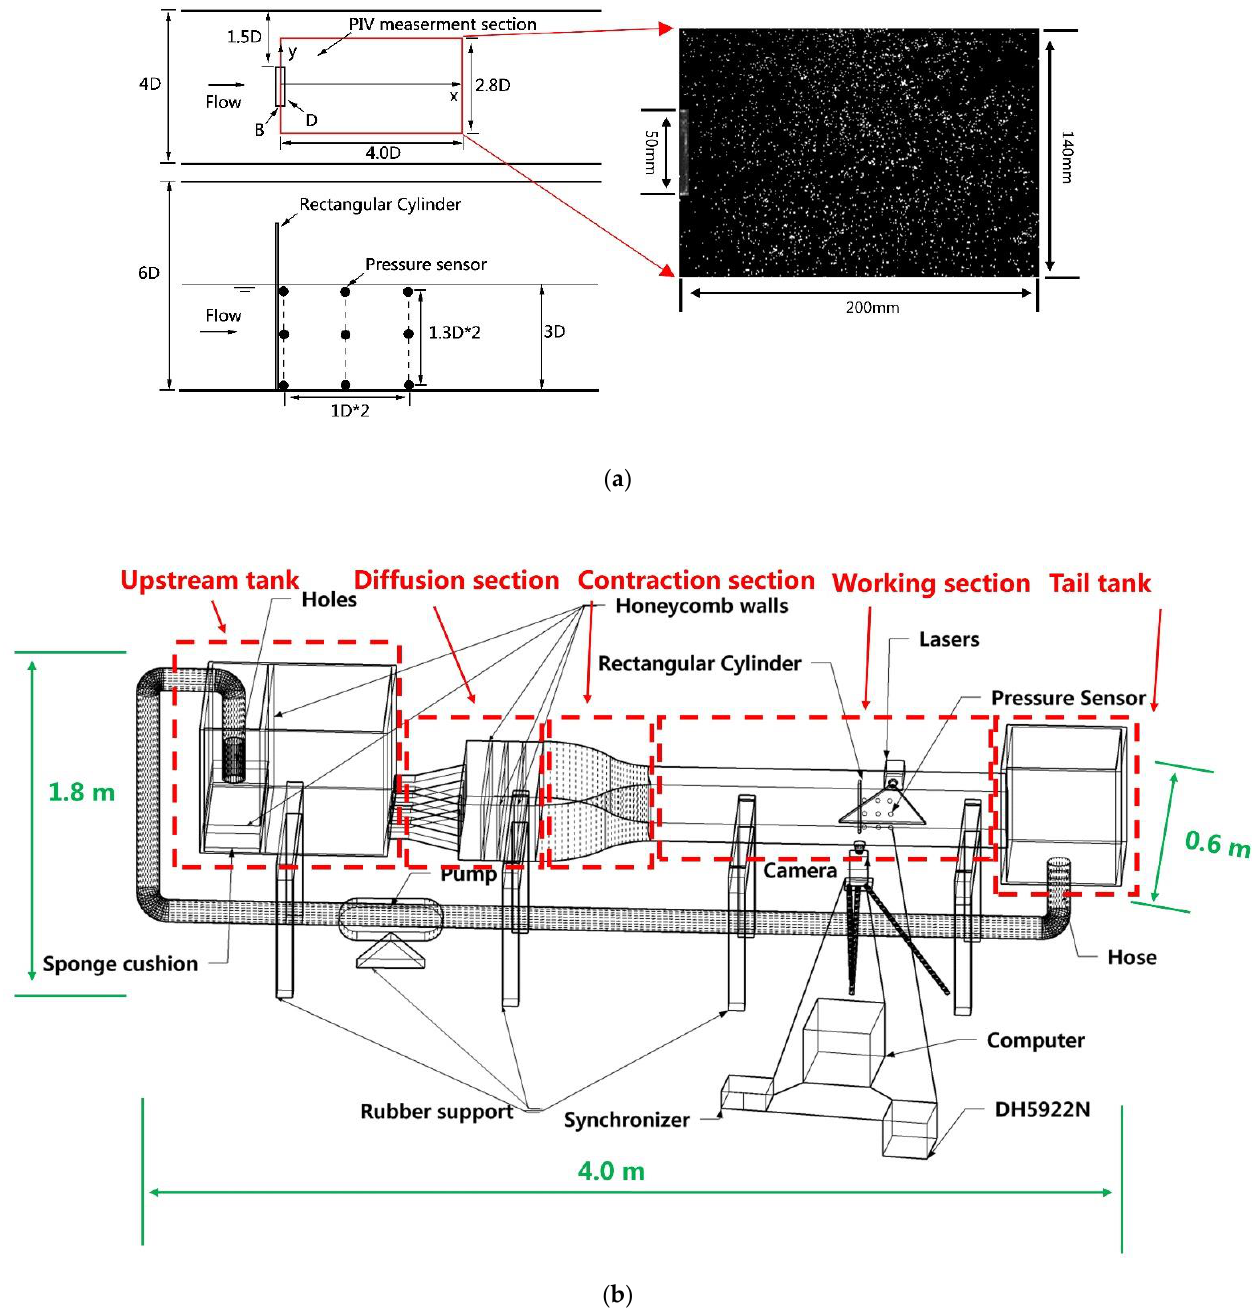
Figure 2. Schematic diagram of the experimental setup: ( a ) Diagram of Pressure sensor arrangement and PIV window; ( b ) Overview of the experiment setep.